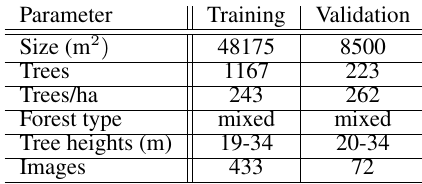
Table 3. Parameters of training and validation areas captured by visual